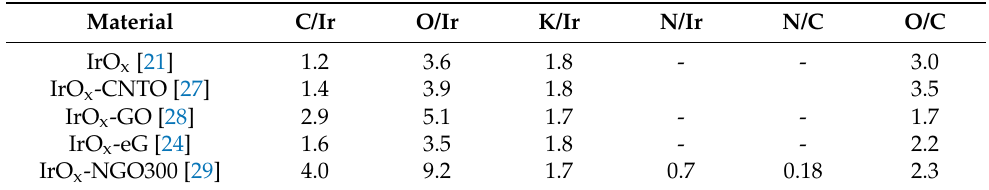
Table 1. Atomic ratios based on XPS analysis for IrO x and IrO x -nanocarbon hybrids. Data from ref. [21,24,27–29].